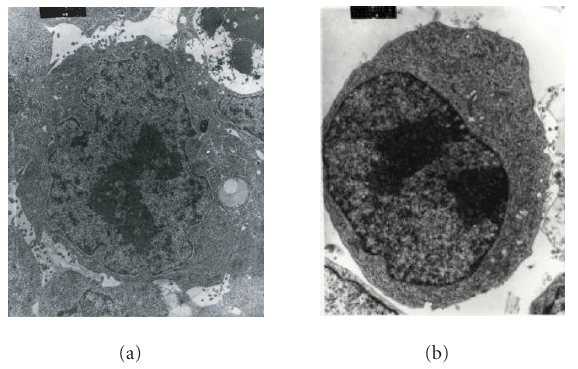
Figure 4. The von Kossa stain.